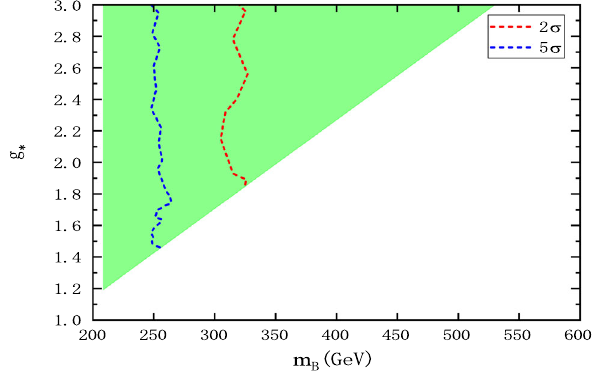
Fig. 6 Parameter space (in green) with respect to the muon g-2 = sin θ μ anomaly for sin θ μ , and the prospect of searching for the L R parameter regions based on the Drell–Yan processes of (cid:8) B at the 14- TeV LHC with an integrated luminosity 3 ab − 1 , with 2 σ exclusion (in red) and 5 σ discovery (in blue) shown simultaneously. See text for